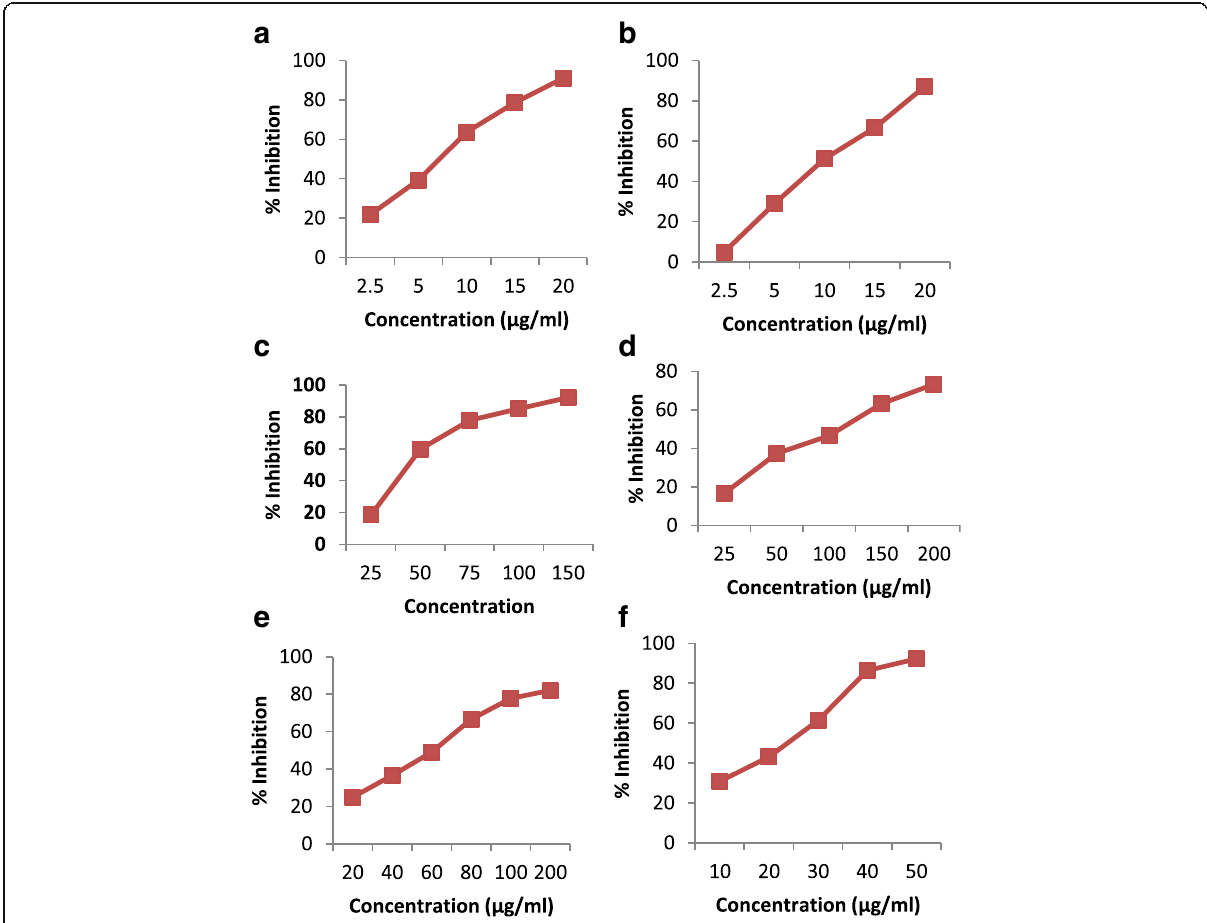
Fig. 1 DPPH free radical scavenging activity of S.caryophyllatum a Ascorbic acid; b Gallic acid; c Bark methanol; d Leaf methanol; e Fruit pulp methanol; f Seed